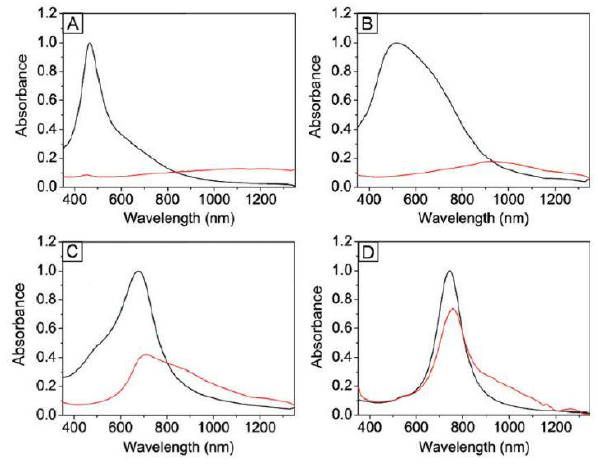
Figure 13. UV-vis-NIR spectra of the samples that correspond to the Au-Ag alloy nanoboxes and nanocages shown in Figure 5. The spectra in black are for the starting Au-Ag nanoboxes and the spectra in red are for the resulting Au-based nanocages after a reaction with an excess amount of H O . For the nanoboxes, the LSPR peaks were at ( A ) 460; 2 2 ( B ) 520; ( C ) 675; and ( D ) 745 nm. The spectra were normalized to unity. For the nanocages, the LSPR peak was red-shifted to the near-infrared region for the first two samples of nanocages due to their extremely thin walls. The spectra were normalized by dividing the same factor to the corresponding spectra of the nanobox (reprinted with permission from